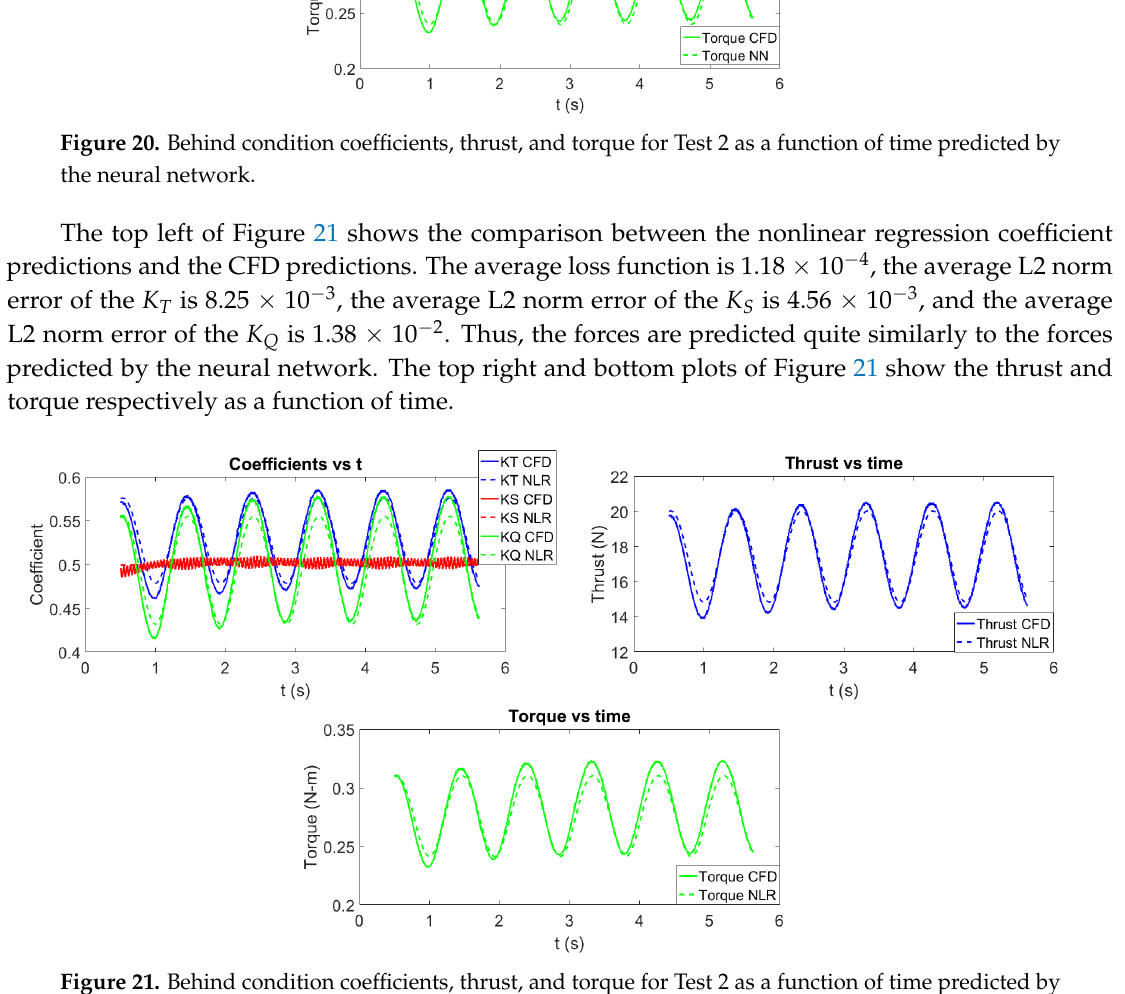
Figure 21. Behind condition coefficients, thrust, and torque for Test 2 as a function of time predicted by nonlinear